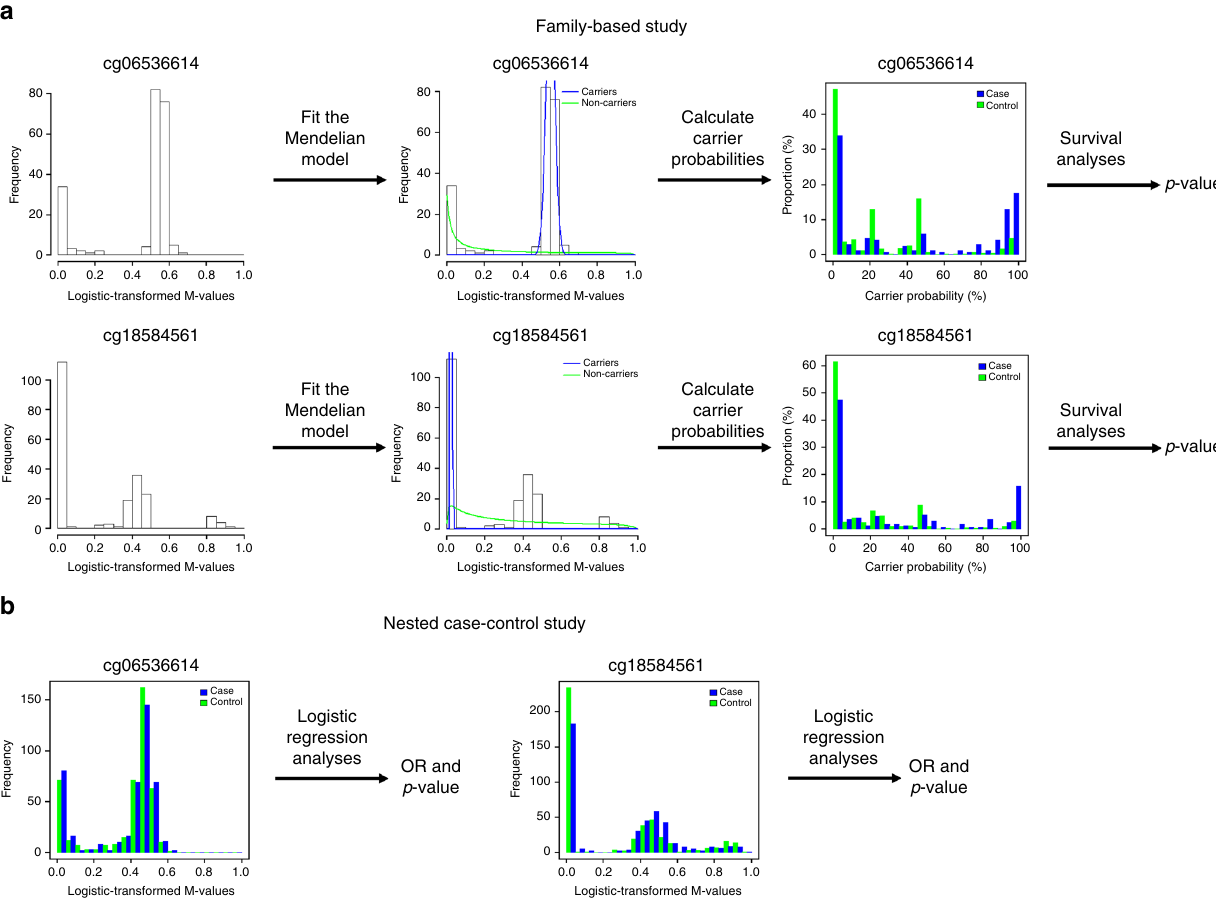
Fig. 3 Analytical study approach. An overview of the analytical approach for each of the 1000 most-Mendelian probes in the multiple-case family-based analyses ( a ) and for the replication study of 24 probes in the population-based, case – control analyses ( b ). A measure of Mendelian heritability was calculated for all probes not on a sex chromosome or within 10 base pairs of a SNP (not depicted). For each of the 1000 most-Mendelian probes, a Mendelian model was fi tted to the probe ’ s M -values and this was used to calculate carrier probabilities (e.g., for a hypothetical genetic variant that causes aberrant DNA methylation at the probe), then these carrier probabilities were tested for association with breast cancer (note that unbiased p -values could be calculated but unbiased risks could not because we could not adjust for ascertainment). This gave 24 highly heritable methylation marks that were associated with breast cancer, and a nested case – control study was used to test the M -values of each of these probes for association with breast cancer and to estimate the corresponding odds ratios